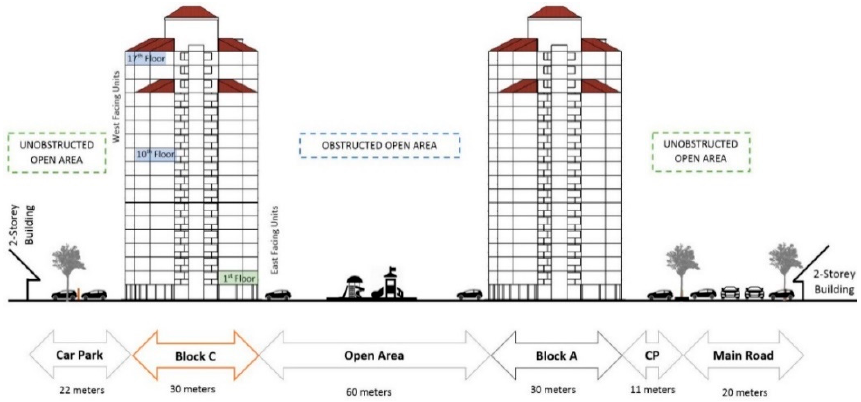
Figure 6. Site section of the PPR Beringin.